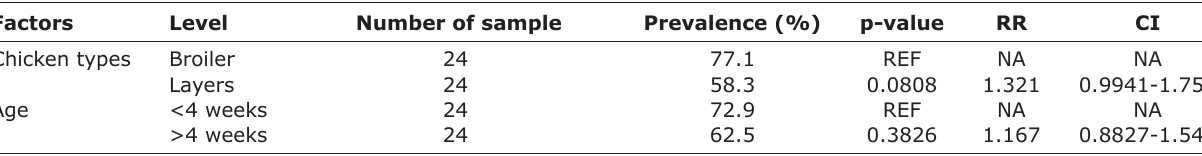
Table-2: Occurrence of E. coli in chickens from small-scale poultry farms in Maiduguri based on chicken types and age. Factors